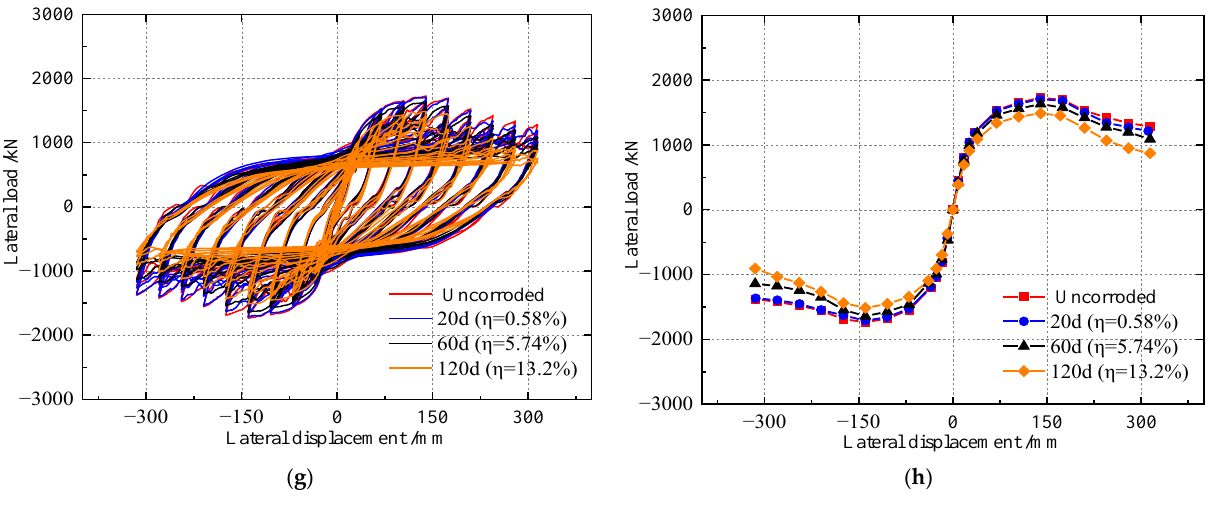
Figure 14. Comparison of SPSWs under different corrosion days: ( a ) Hysteretic curves of FSPSW; ( b ) Envelop curves of FSPSW; ( c ) Hysteretic curves of OSPSW; ( d ) Envelop curves of OSPSW; ( e ) Hysteretic curves of VSSPSW; ( f ) Envelop curves of VSSPSW; ( g ) Hysteretic curves of BSPSW; ( h ) Envelop curves of BSPSW.